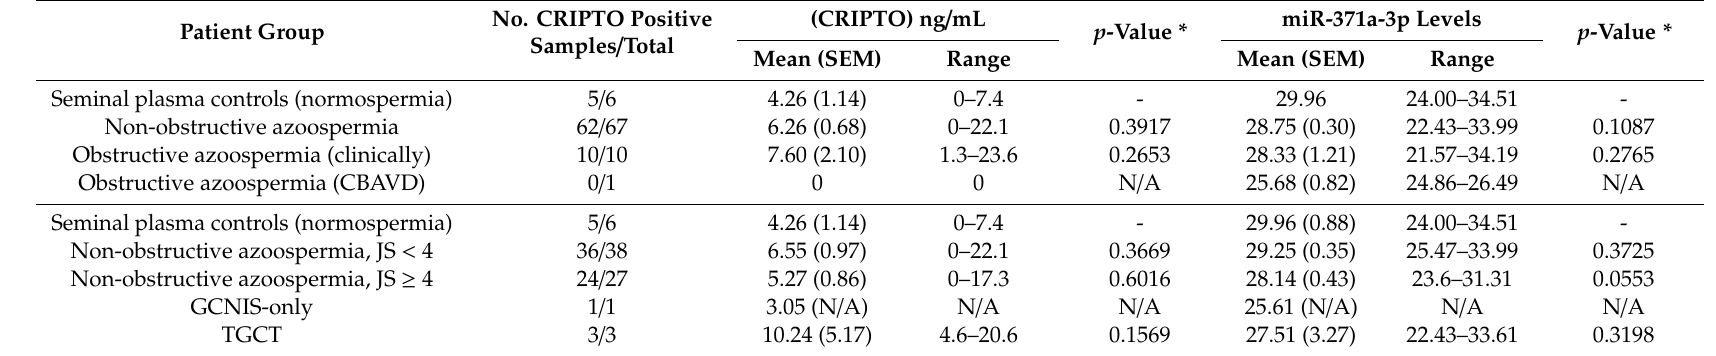
Table 4. CRIPTO concentration and miR-371a-3p levels in seminal plasma